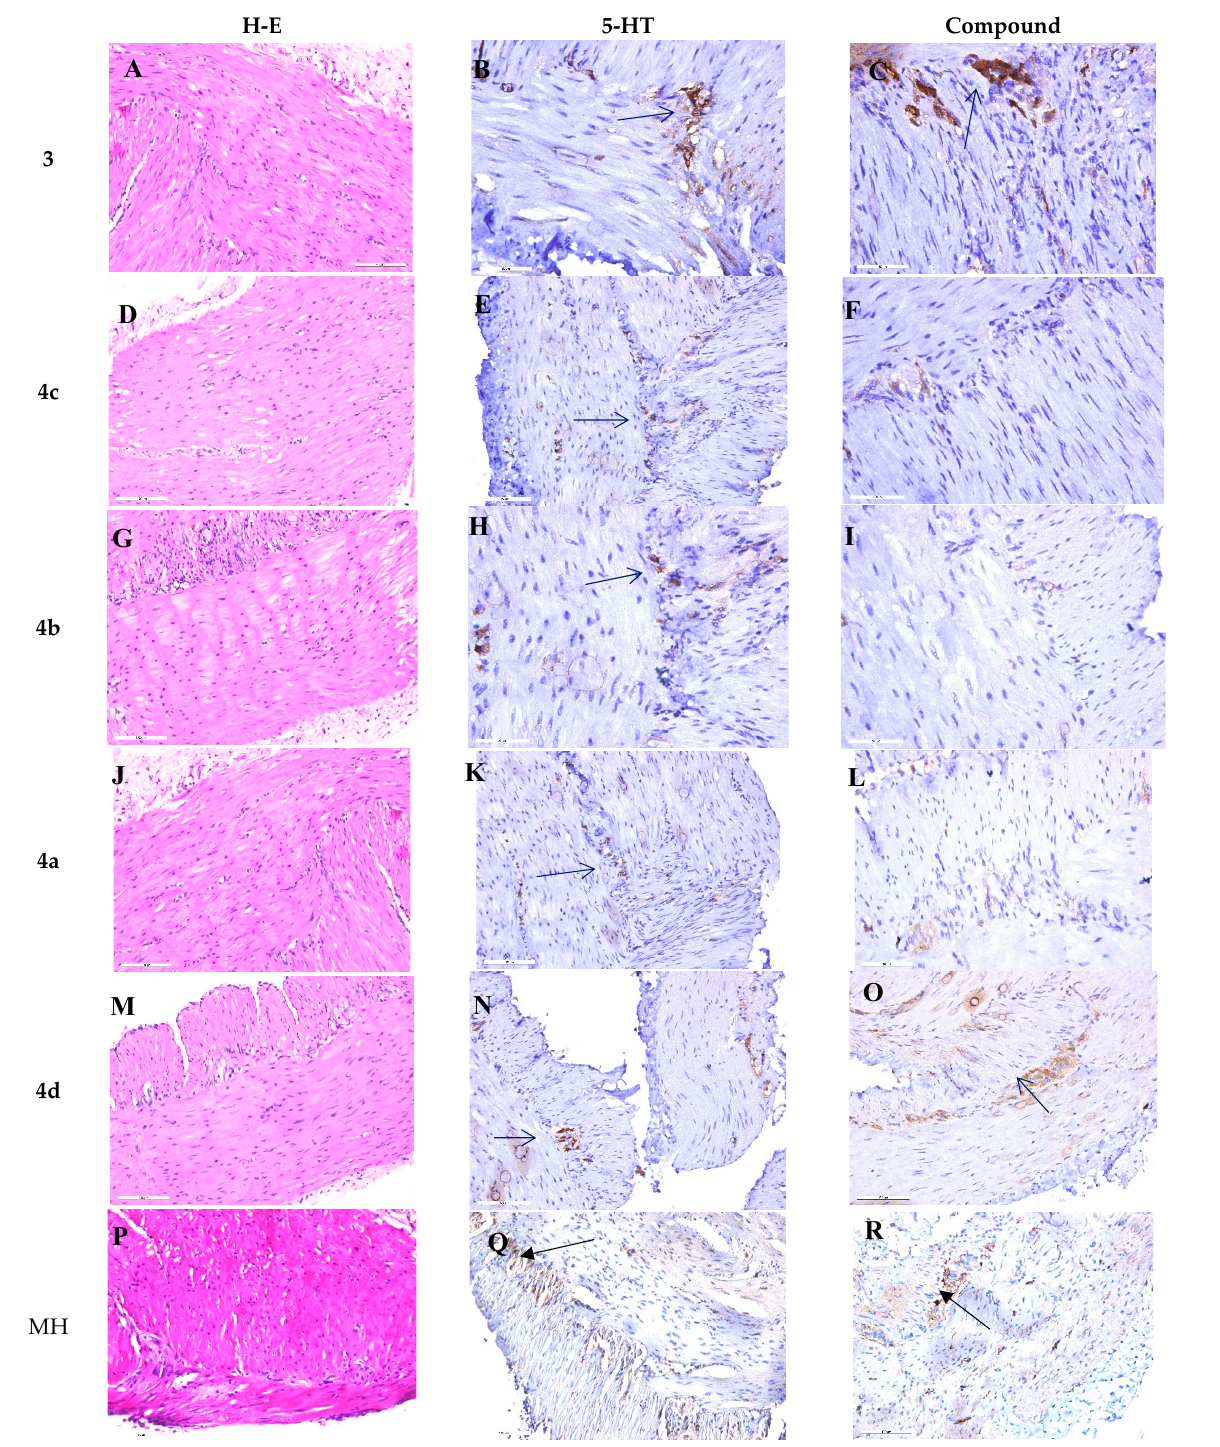
Figure 5. Histological and immunohistochemical staining of SM preparations after 1 h incubation period. ( A , D , G , J , M , P ) were incubated with 3 , 4a – d and mebeverine hydrochloride (MH), H-E staining, × 20; ( B , E , H , K , N , Q ) were incubated with 5-HT, 5-HT3 expression in myenteric plexus observed (black arrows), × 20; ( C ) was incubated with 3 , increased intensity in 5-HT3 expression in myenteric plexus observed (black arrows), × 20; ( F ) was incubated with 4c , no 5-HT3 expression observed, × 20; ( I ) incubated with 4b , no 5-HT3 expression observed, × 20; ( L ) incubated with 4a , no 5-HT3 expression observed, × 20; ( O ) incubated with 4d , weak 5-HT3 expression observed (black arrows), × 20; ( R ) was incubated with MH, weak 5-HT3 expression observed (black arrows), ×